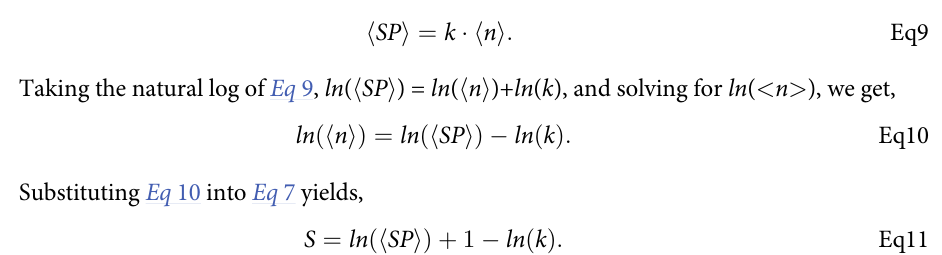
Substituting Eq 10 into Eq 7 yields,